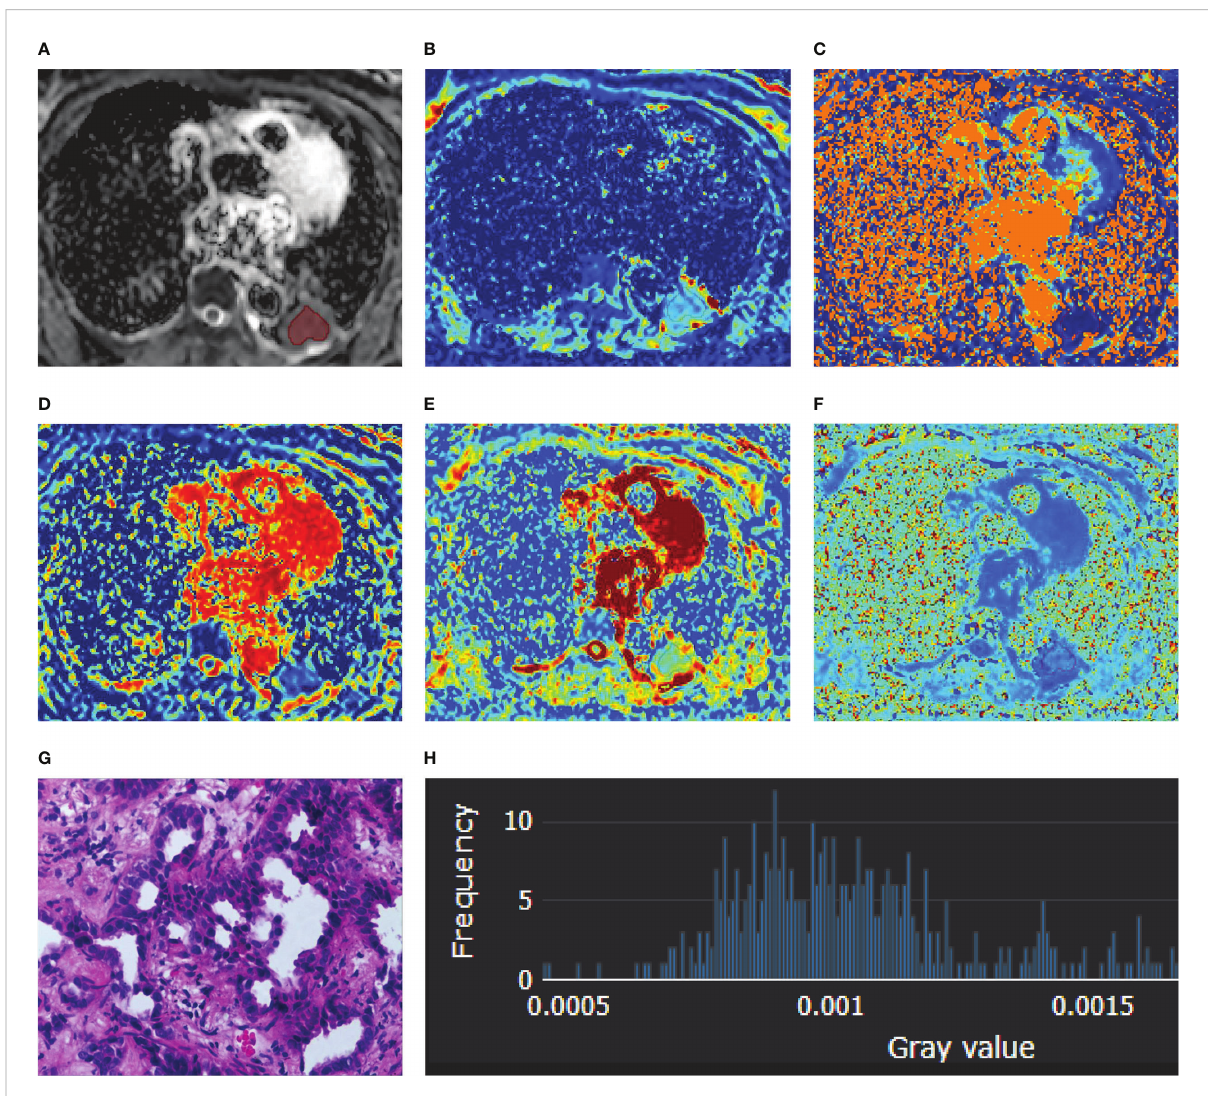
FIGURE 1 A 56-year-old female diagnosed with adenocarcinoma of the left lower lobe. (A) ADC map; (B) D map; (C) D* map; (D) f map (E) Dapp map; (F) Kapp map; (G) microscopic image of H&E staining (original magni fi cation, ×200); (H) an example diagram of the